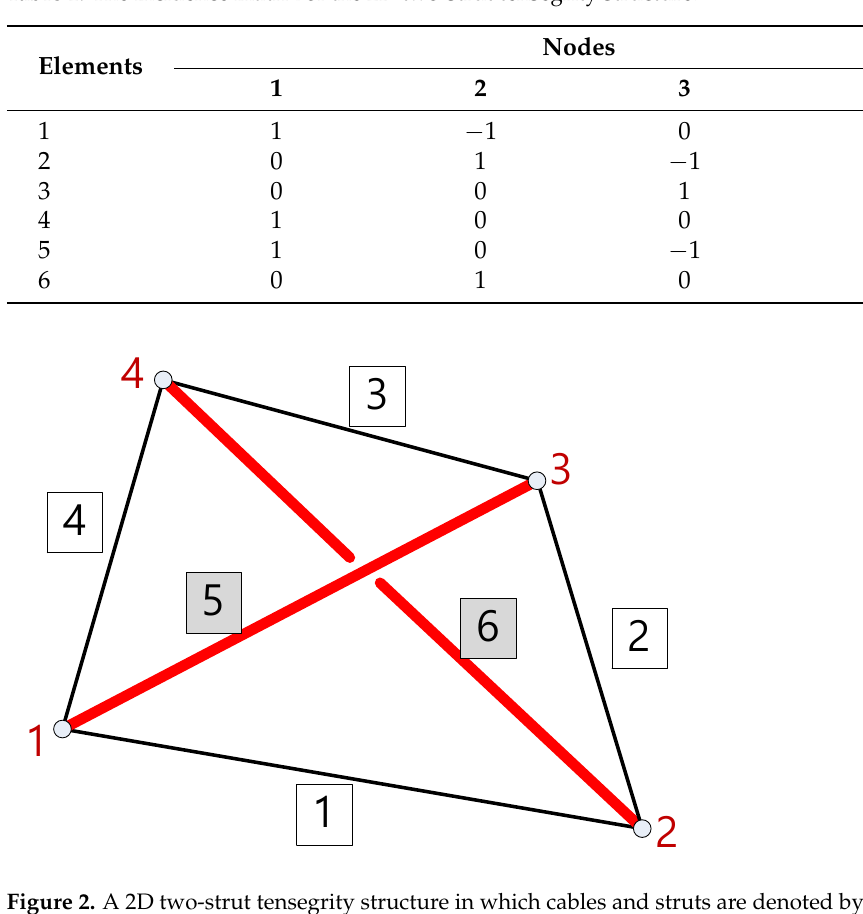
Table 1. The incidence matrix of the 2D two-strut tensegrity structure.